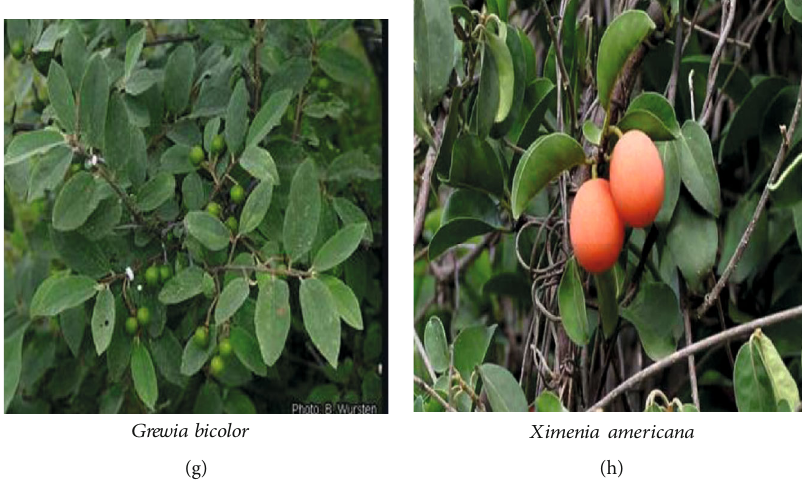
Figure 2: List of commonly consumed wild edible fruits (a –